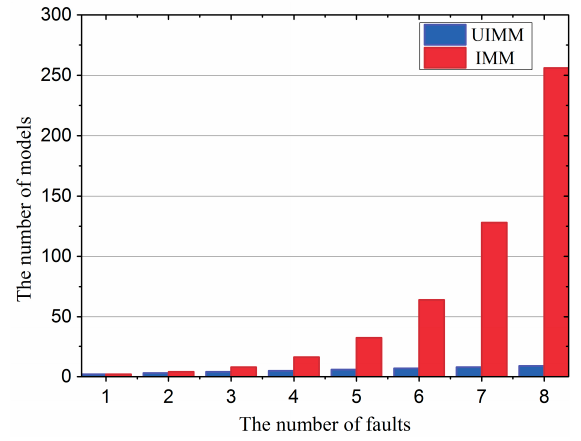
Figure 4. The comparison of the numbers of models required by IMM and the proposed UIMM.